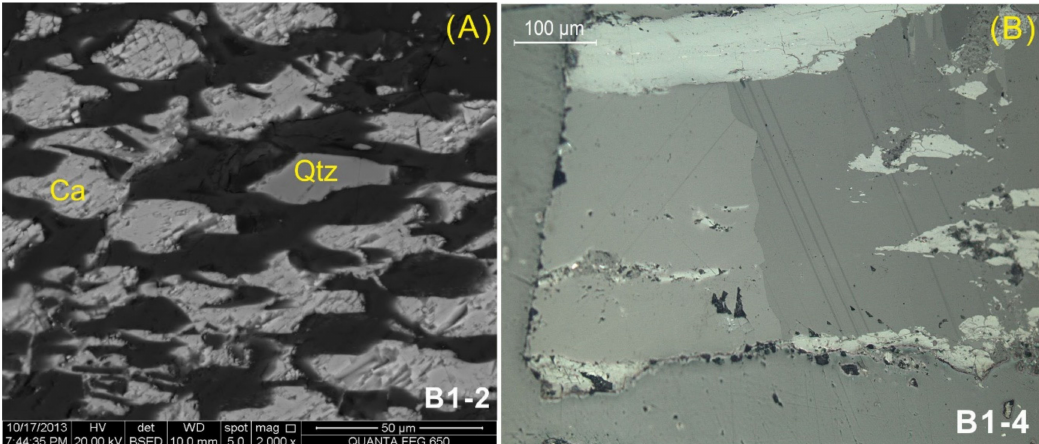
Figure 9. Calcite in the coal samples. ( A ) Cell-filling calcite and quartz in sample B1-2, back-scattered electron image. ( B ) Fracture-filling calcite in sample B1-4, optical microscope, reflected light. Qtz: quartz. Ca: calcite.